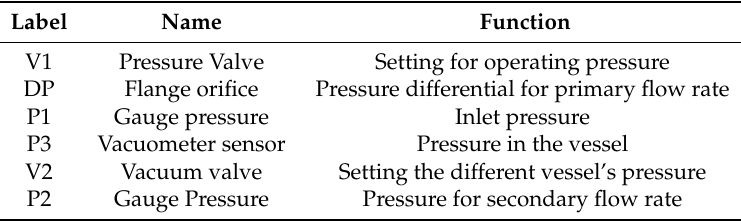
Figure 2. Experimental setup used in LABSON laboratories. Table 1. Data for the experimental